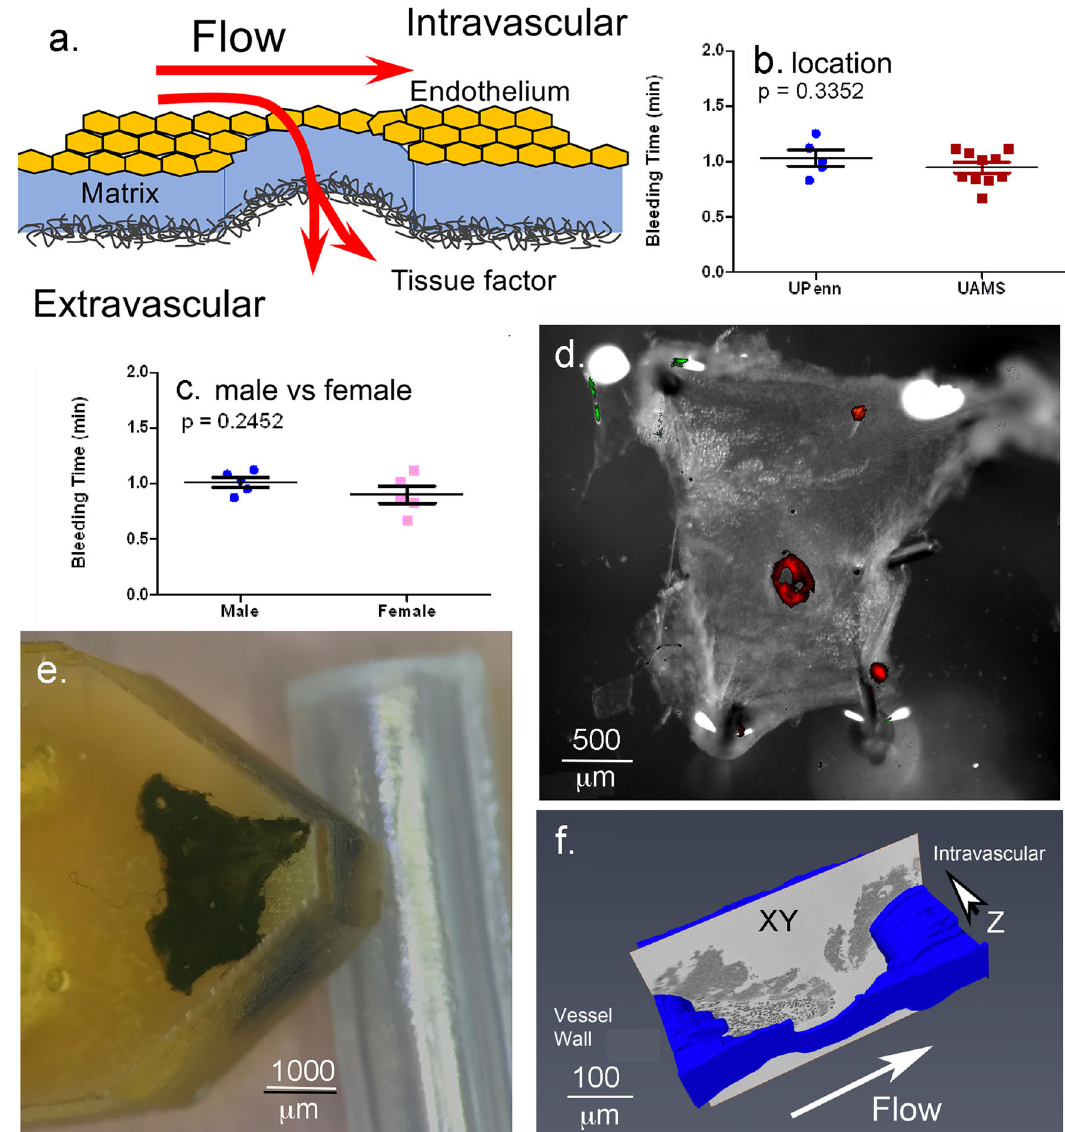
Fig. 1 Experimental system. a Schematic of fl ow and tissue factor exposure in a jugular vein puncture wound. Tissue factor exposure leads to coagulation factor activation, e.g., thrombin generation. b , c Bleeding time cessation times at the two different locations where punctures were performed and the effect of mouse sex on bleeding times, mean plus and minus standard deviation. Comparative positioning of the thrombus (red fl uorescence in ( d )). Upon opening the jugular vein ( d ) and embedding in plastic ( e , f ). Schematic of repeated, SBF-SEM imaging across the puncture wound hole. The resulting image slices are positioned so that fl ow is from left to right and the direction of progressive block face exposure into the plane of the